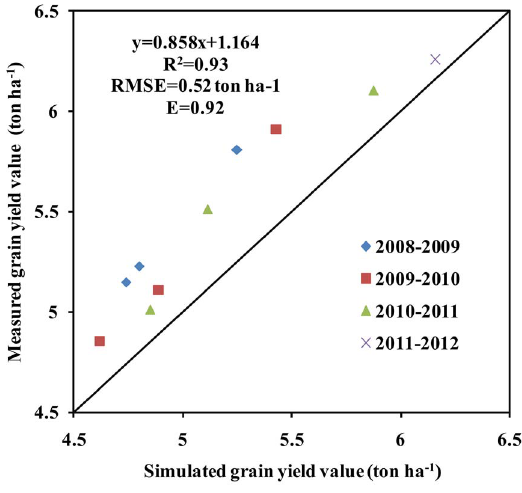
Figure 6. Relationship between the measured and simulated grain yield (GY) in winter wheat across 4 years. Note: x represents the simulated GY, y represents the measured GY. The intercept represents the relative error between the simulated GY and the measured GY. The slope represents the consistency between the simulated GY and the measured GY.